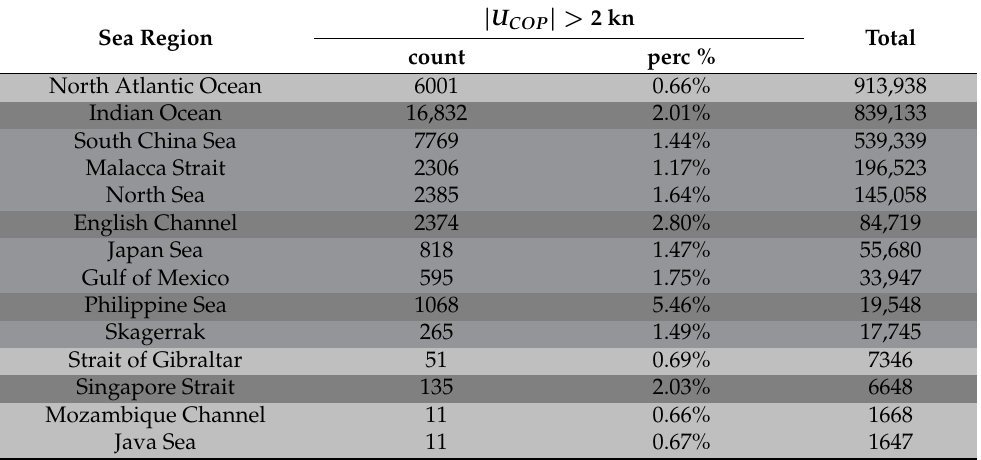
Table 14. Sea surface currents speed projection on ship’s true heading U COP above 2 kn boundary decomposed by sea name where the ships have been sailing. Only those seas where the percentage column is greater than 0.63% have been included. Gray background gets darker when the percentage column of | U COP | > 2 kn